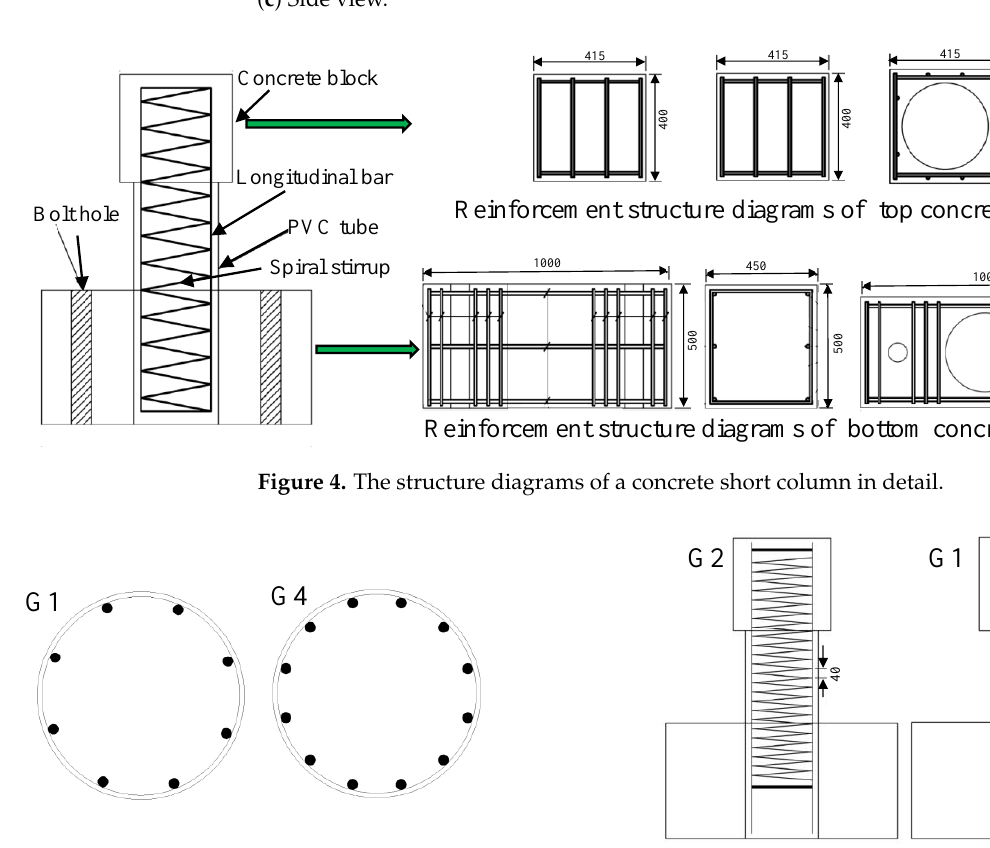
Figure 3. The size of a concrete short column and its concrete blocks. ( a ) Top view; ( b ) Front view; ( c ) Side view.